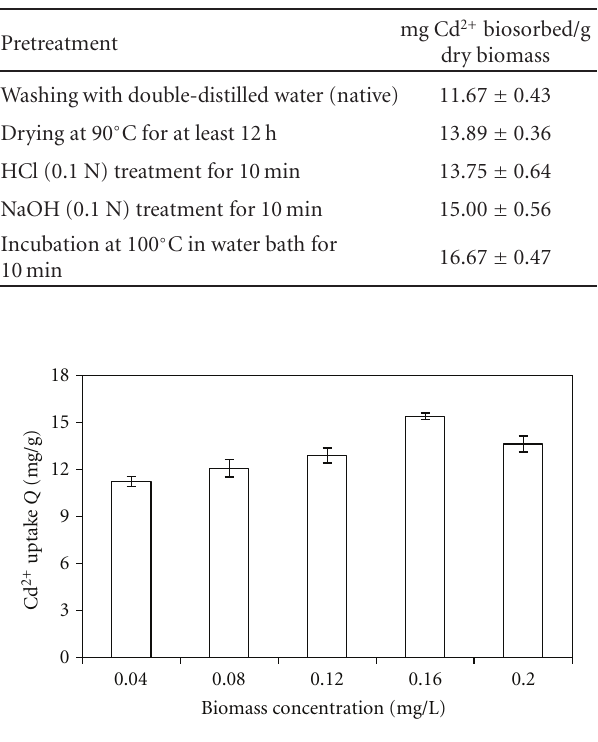
Table 1: E ff ect of biomass pretreatments on biosorption of Cd(II) by Oscillatoria sp.